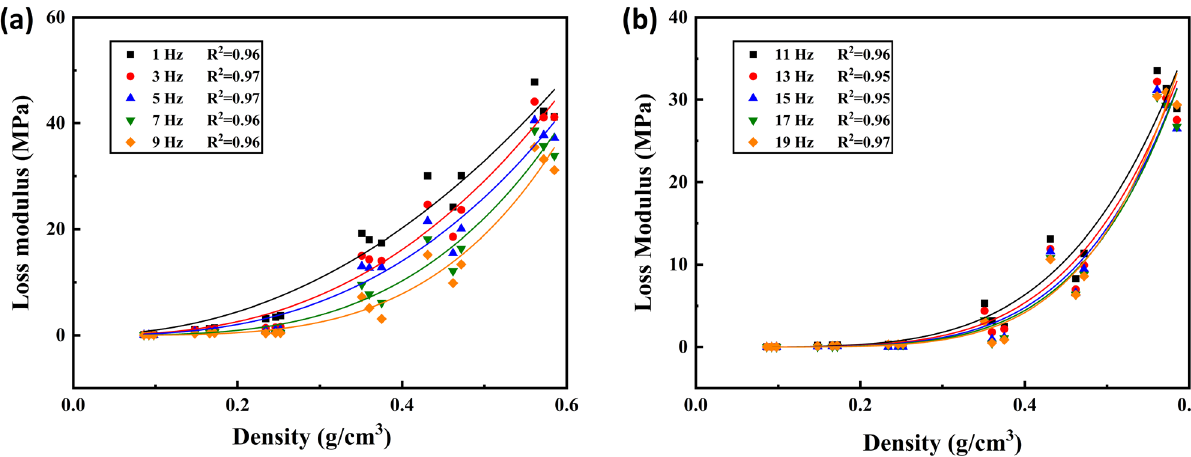
Figure 11: Relationship between density and loss modulus of polyurethane grounding materials ( 25°C ) : ( a ) fi tting results ( 1 – 9 Hz ) and ( b ) fi tting results ( 11 – 13 Hz )